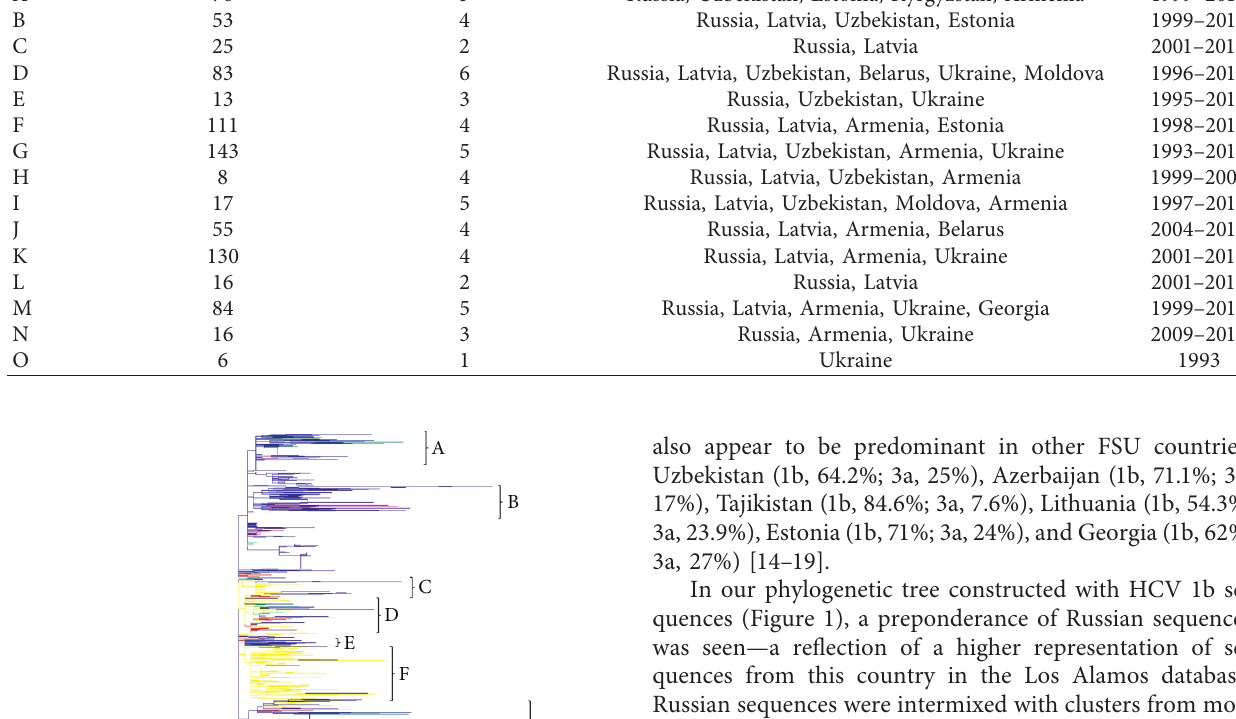
Table 3: Cluster analysis of HIV env tree in Figure 3 showing distribution of sequences among FSU countries. Cluster